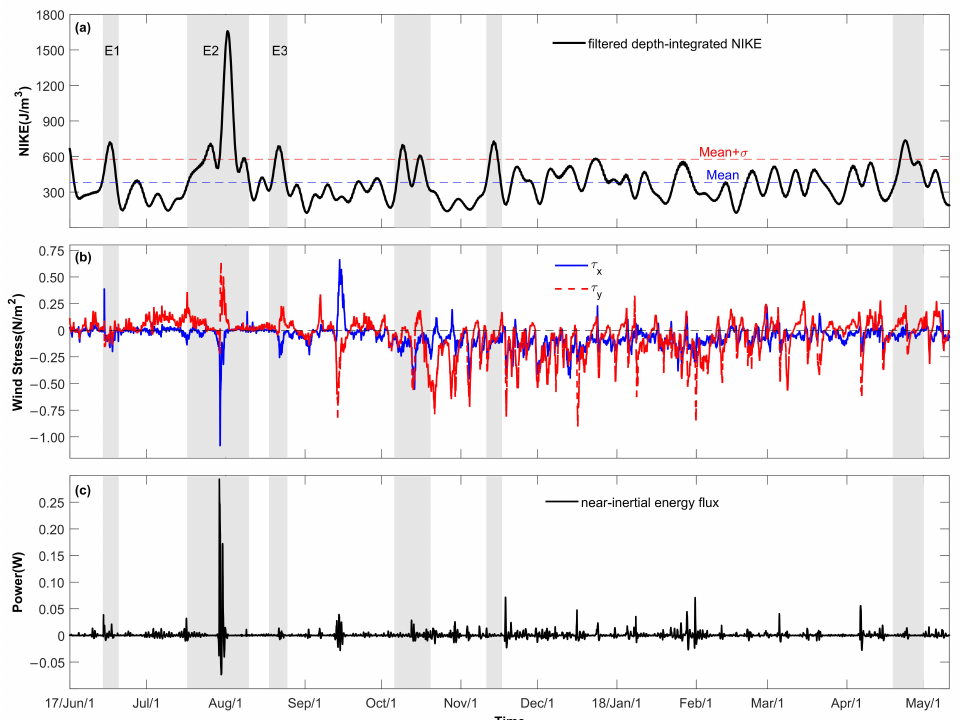
Figure 6. ( a ) Low-passed filtered depth-integrated NIKE; ( b ) zonal and meridional wind stress; ( c ) near-inertial energy flux from wind to ocean. In figure ( a ), the blue and red dashed horizontal lines represent the mean and upper one standard deviation of the depth-integrated NIKE, respectively. In figure ( b ), the blue and red lines represent the zonal and meridional wind stress. The six episodes with NIKE exceeding one standard deviation are